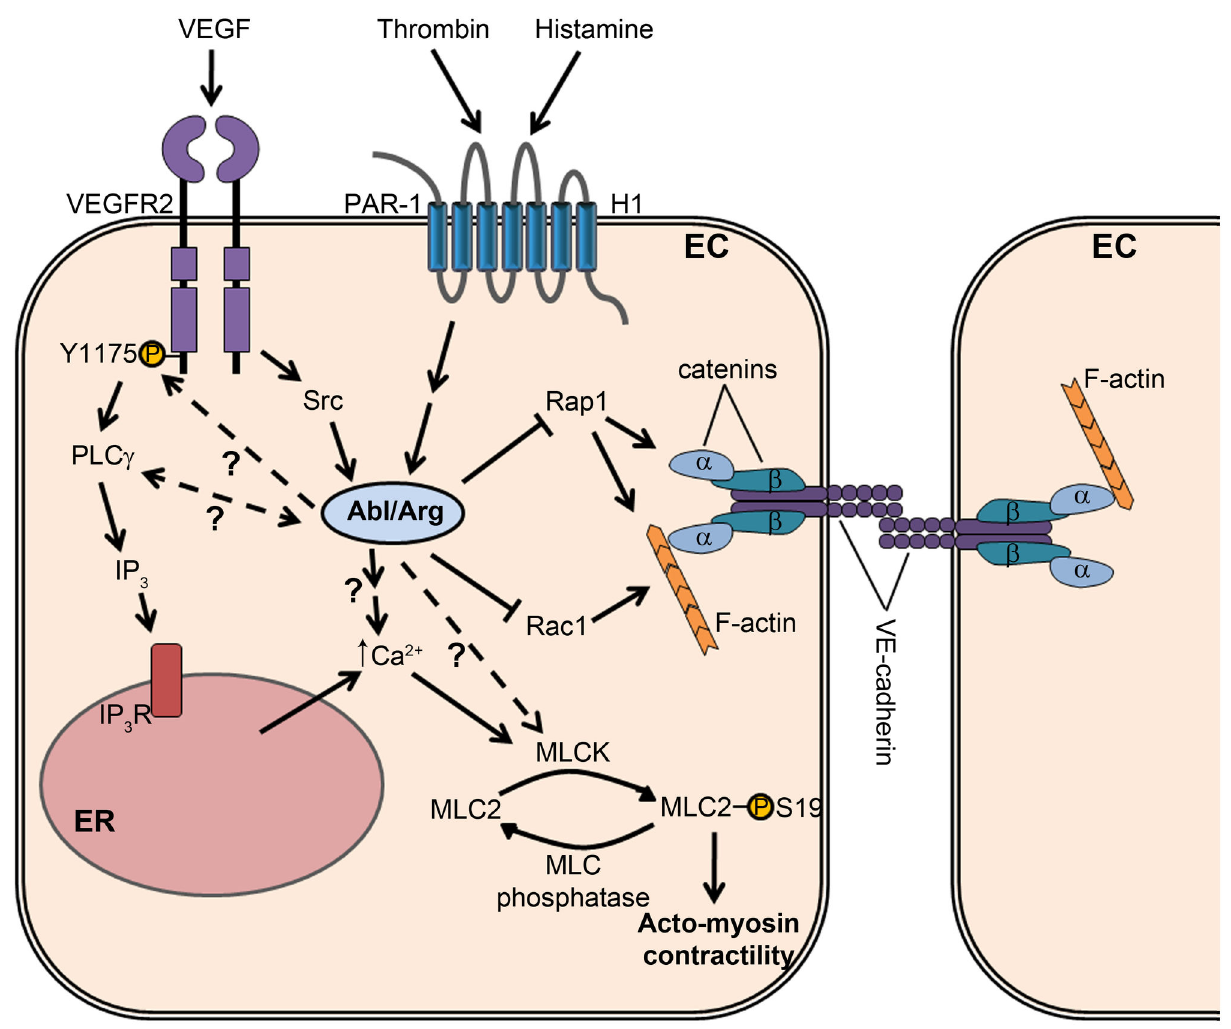
Figure 7. Model for the role of the Abl family kinases in signaling pathways regulating endothelial permeability. The Abl and Arg kinases are activated in endothelial cells downstream of receptors for the permeability-inducing factors VEGF, thrombin, and histamine. VEGF-mediated Abl kinase activation requires Src family kinase activity. The Abl kinases positively regulate phosphorylation of MLC2 (S19) in response to these permeability-inducing agonists, likely through regulating the activity of Ca 2+ / calmodulin-dependent targets such as MLCK. Abl kinase activity is required for maximal Ca 2+ mobilization in response to stimulation with permeability-inducing factors. The Abl kinases additionally modulate VEGF-induced phosphorylation of VEGFR2 at Y1175, which regulates downstream PLCγ activation, IP generation, and ER Ca 2+ release. Abl kinases promote Ca 2+ mobilization by 3 thrombin and histamine by mechanisms yet to be characterized. Abl kinases negatively regulate basal activity levels of the Rac1 and Rap1 GTPases, which have been shown to support endothelial barrier function by promoting cortical actin deposition and adherens junction stability. Abbreviations: EC, endothelial cell; VEGF, vascular endothelial growth factor; VEGFR2, VEGF